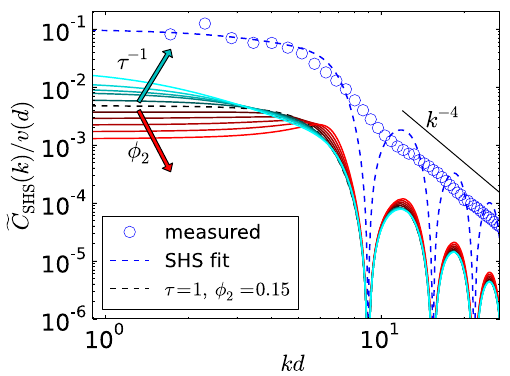
Figure 3. Comparison of measured and fitted Fourier transforms of the correlation function for one snow sample (blue curves). Depen- dence of sticky hard sphere model e C SHS (k | φ 2 , d , τ) on stickiness τ (cyan curves) and volume fraction φ 2 (red curves) around a refer- ence (black dashed line). The dependence of e C SHS (k | φ 2 , d , τ ) on sphere diameter d is captured by using the dimensionless variable kd and normalizing with the sphere volume v(d)